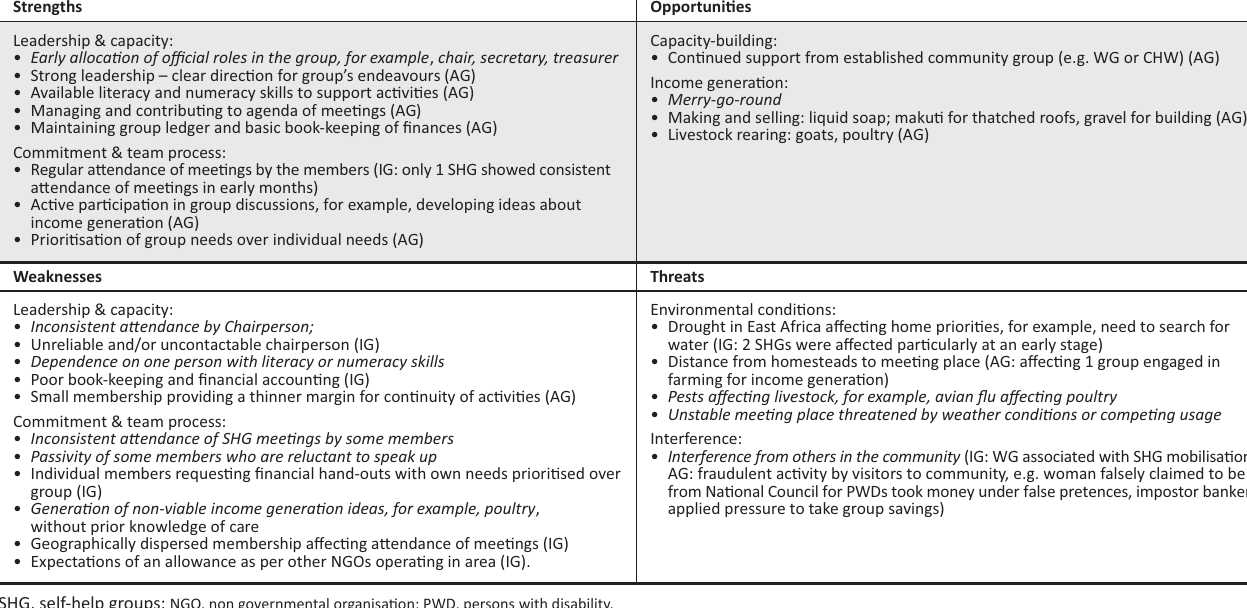
FIGURE 2: Summary of strengths–weaknesses–opportunities–threats analysis for active and inactive groups: shared characteristics and processes indicated in italics (separate characteristics are indicated in brackets: active groups [AG] and inactive groups